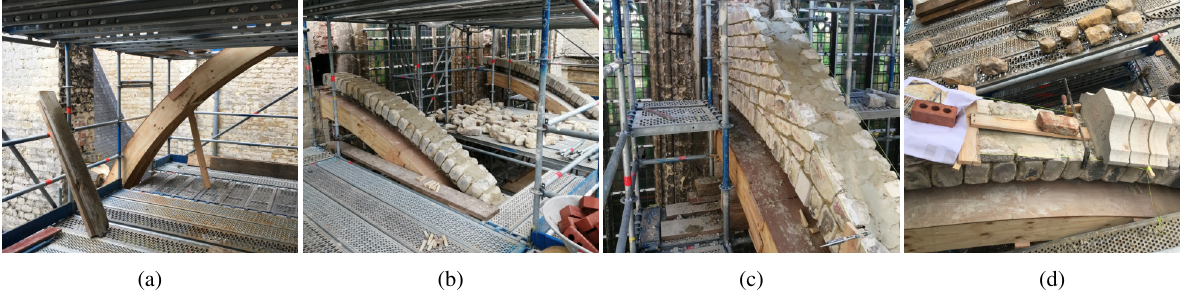
Figure 6: Figure depicting the subsequent steps in the reconstruction process of the flying buttresses (a) supporting formwork (b) first row of force-bearing stone elements (c) inner stone placement (d) top row force-bearing elements placement, note the replica stones substituting missing